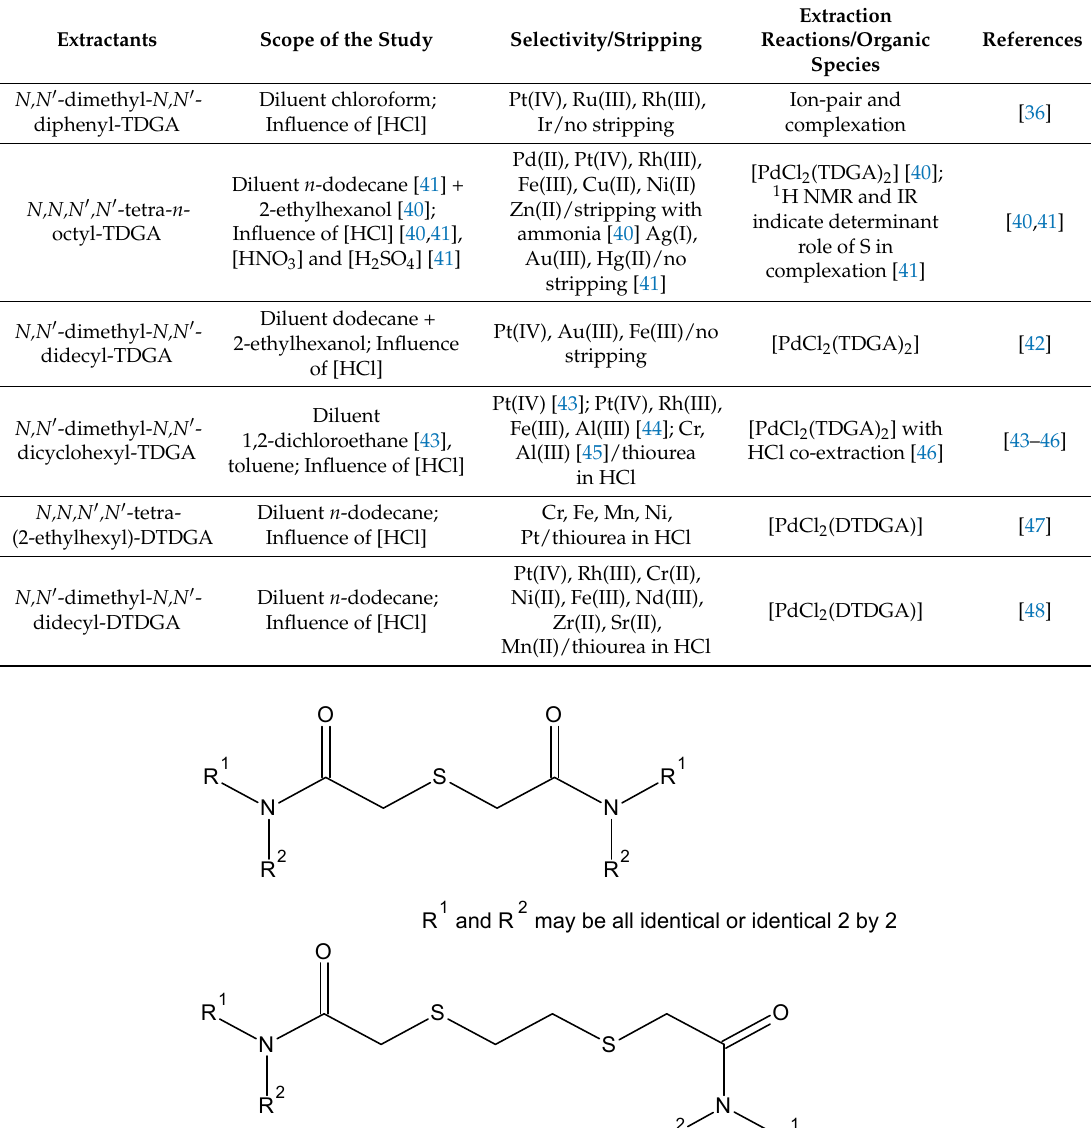
Table 1. Pd(II) extraction by N,N,N (cid:48) ,N (cid:48) -tetrasubstituted thio- and dithio-diglycolamides (TDGA and DTDGA, respectively).